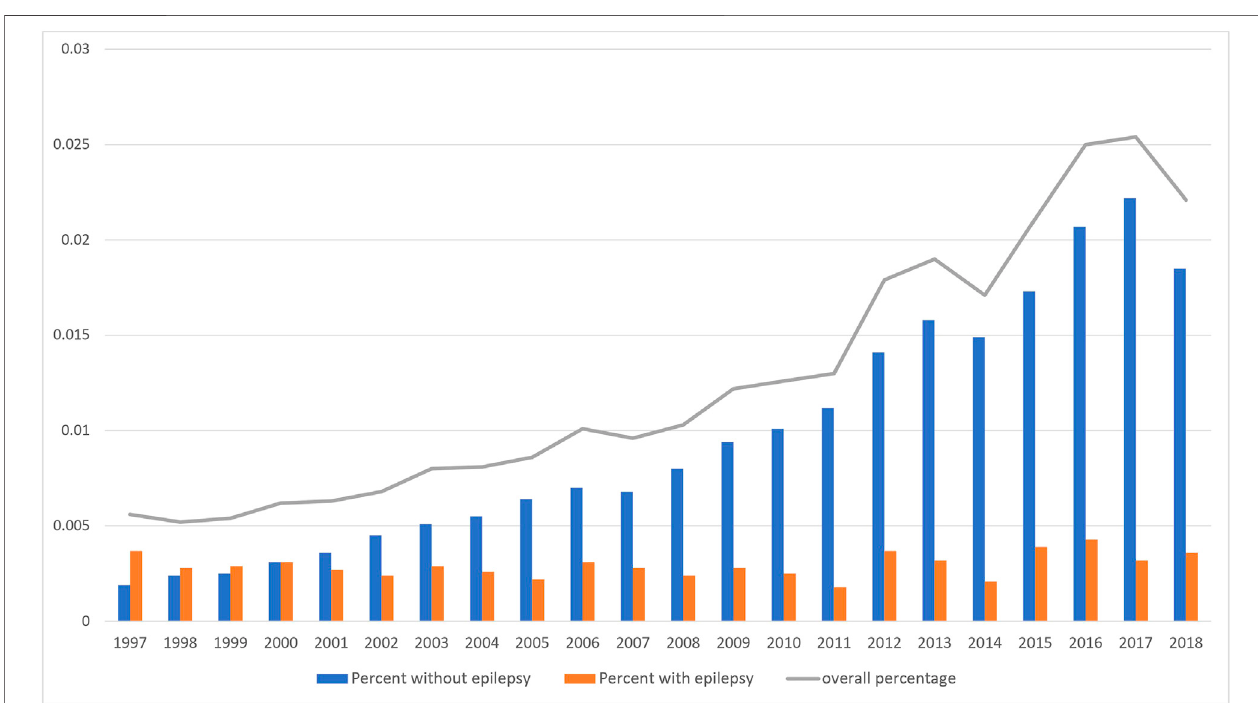
FIGURE 2 | Annual Trend of utilization of ASMs among all pregnant women with and without epilepsy.